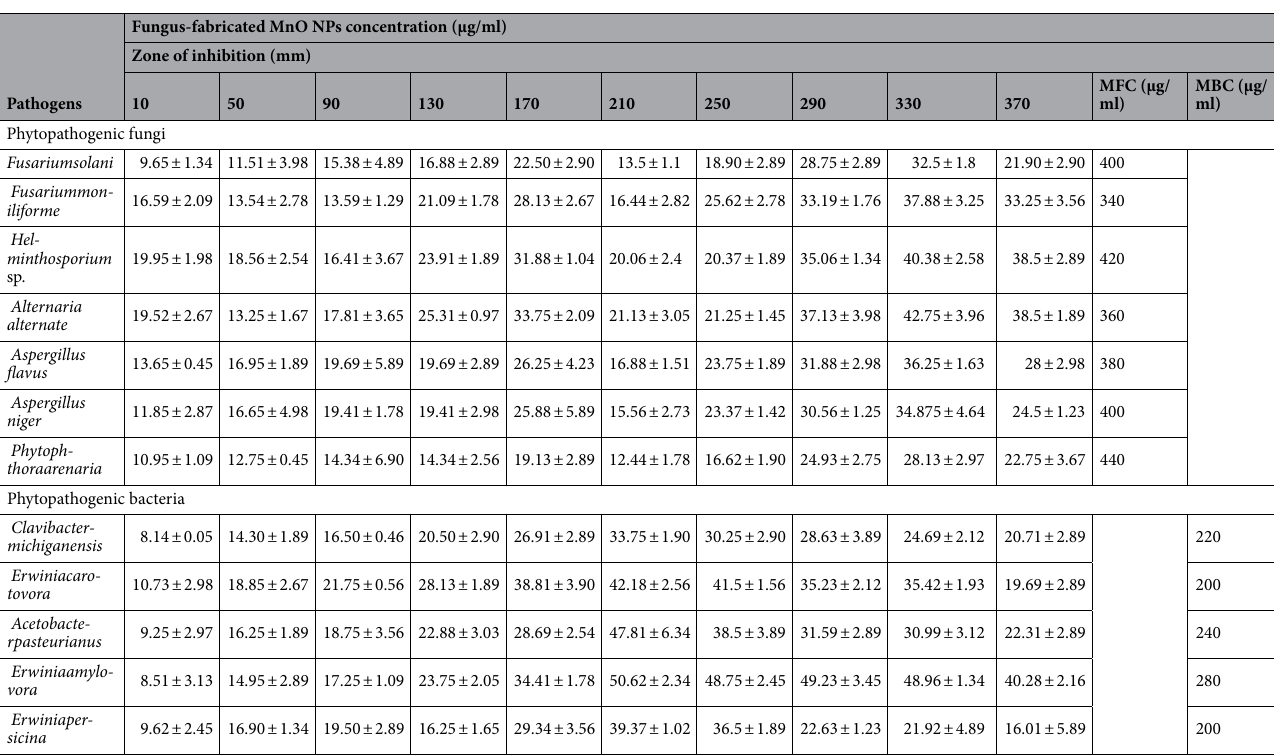
Table 9. Bio-application of the fabricated MnO NPs using the endophytic Trichodermavirens strain EG92against phytopathogens in vitro to detect MIC, MFC, and MBC